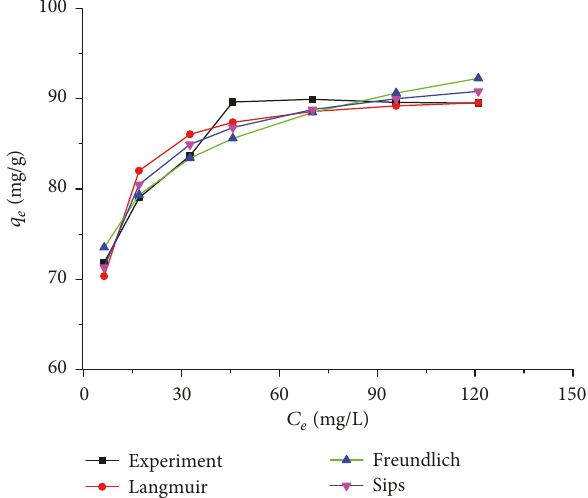
Figure 5: Plots of the adsorption capacity at the equilibrium q 𝑒 versus the equilibrium concentration C 𝑒 obtained within the Langmuir, Freundlich, and Sips nonlinear isotherm models.